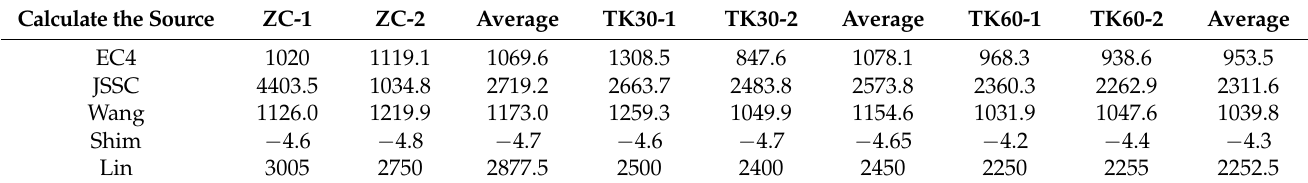
Table 5. The shear stiffness of specimens.